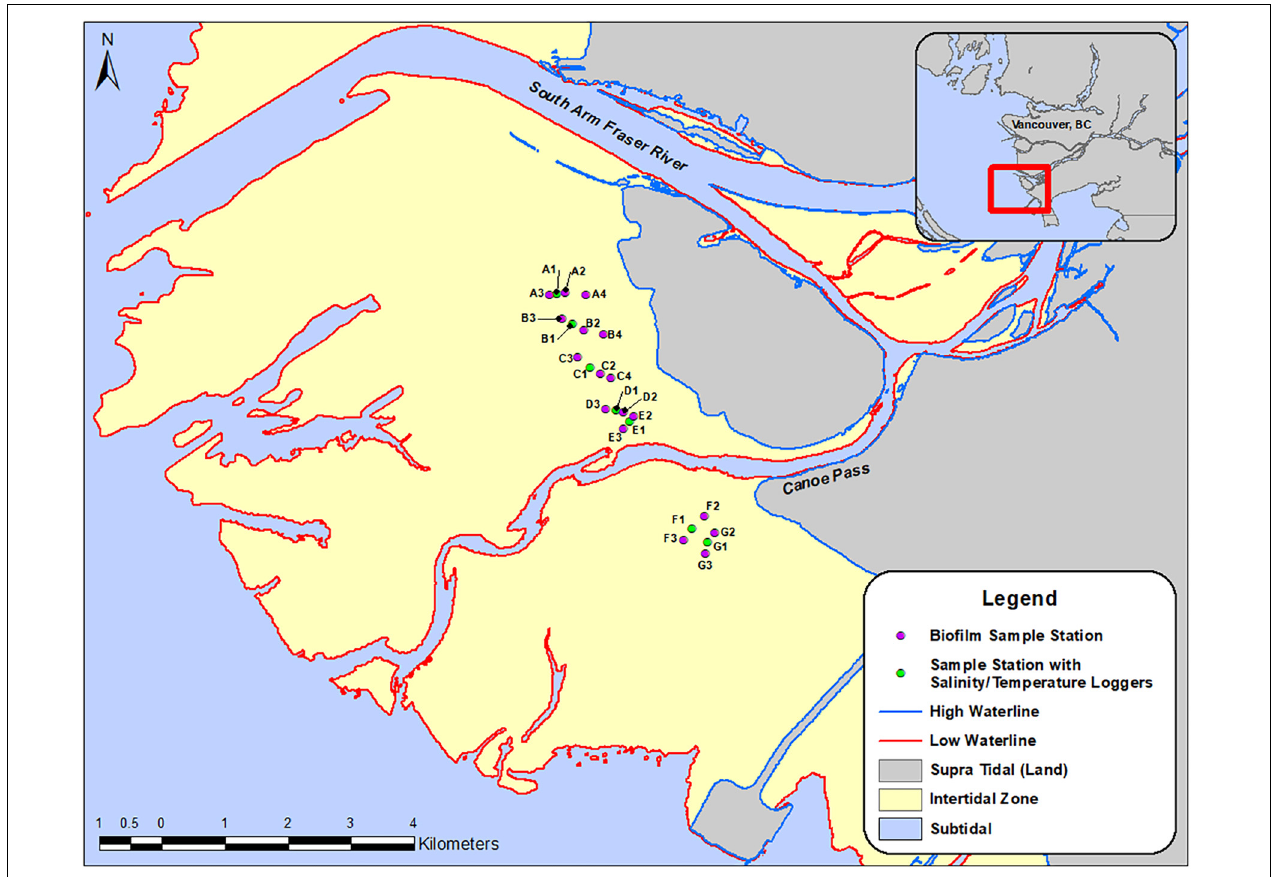
FIGURE 1 | Map of the Roberts Bank study site, with symbols indicating biofilm-sampling locations, April-September 2017. Inset shows the region south of the city of Vancouver, British Columbia, Canada, and the location of the study area within the outflow of the south arm of the Fraser River. Round symbols indicate sampling stations for biofilm measures, and stations in red included monitoring units for salinity and